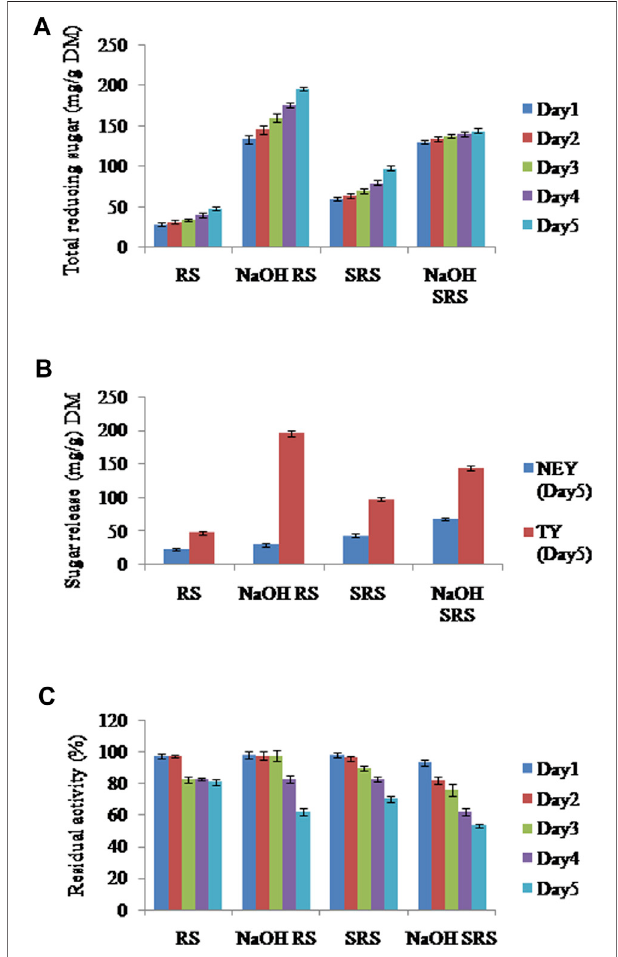
FIGURE3|(A) Releaseofreducingsugars from different strawsamples during 5 days of HTSS (B) Total yield (TY) and non-enzymatic yield (NEY) of sugars from untreated and alkali pre-treated straw samples after 5 days of HTSS (C) Residual activity of xylanases in the different sacchari fi cation mixes during 5 days of